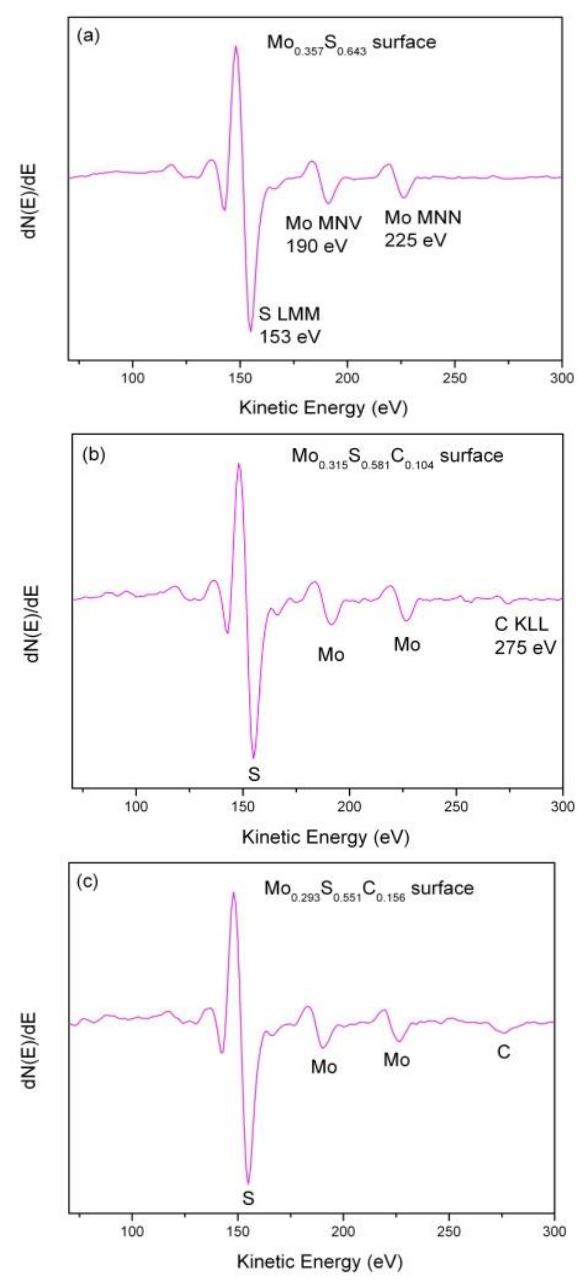
Figure 1. Auger electron spectroscopy (AES) spectra of the sputter-cleaned (3 kV Ar + ions, 30 s) molybdenum disulfide flakes with increasing S/Mo ratio prior to elastic-peak electron spectroscopy (EPES) measurements: ( a ) S/Mo = 1.80; ( b ) S/Mo = 1.84; ( c ) S/Mo = 1.88.